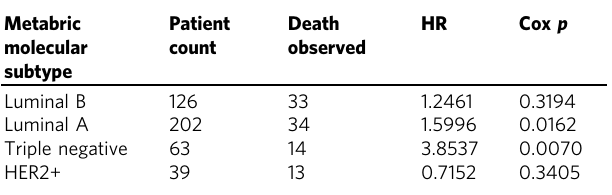
Table1 CINP score potential to predict prognosis in stage I patients from metabric database broken down by molecular